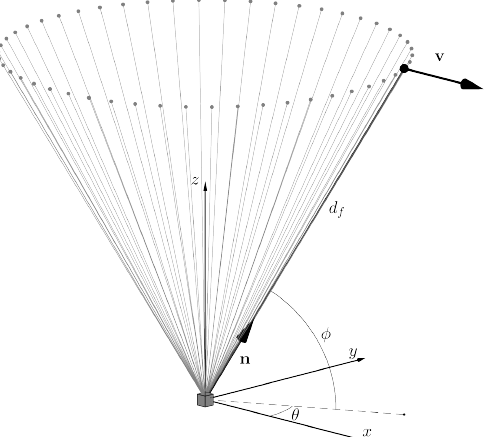
Figure 1. A typical VAD configuration, where the lidar scans at 50 azimuthal